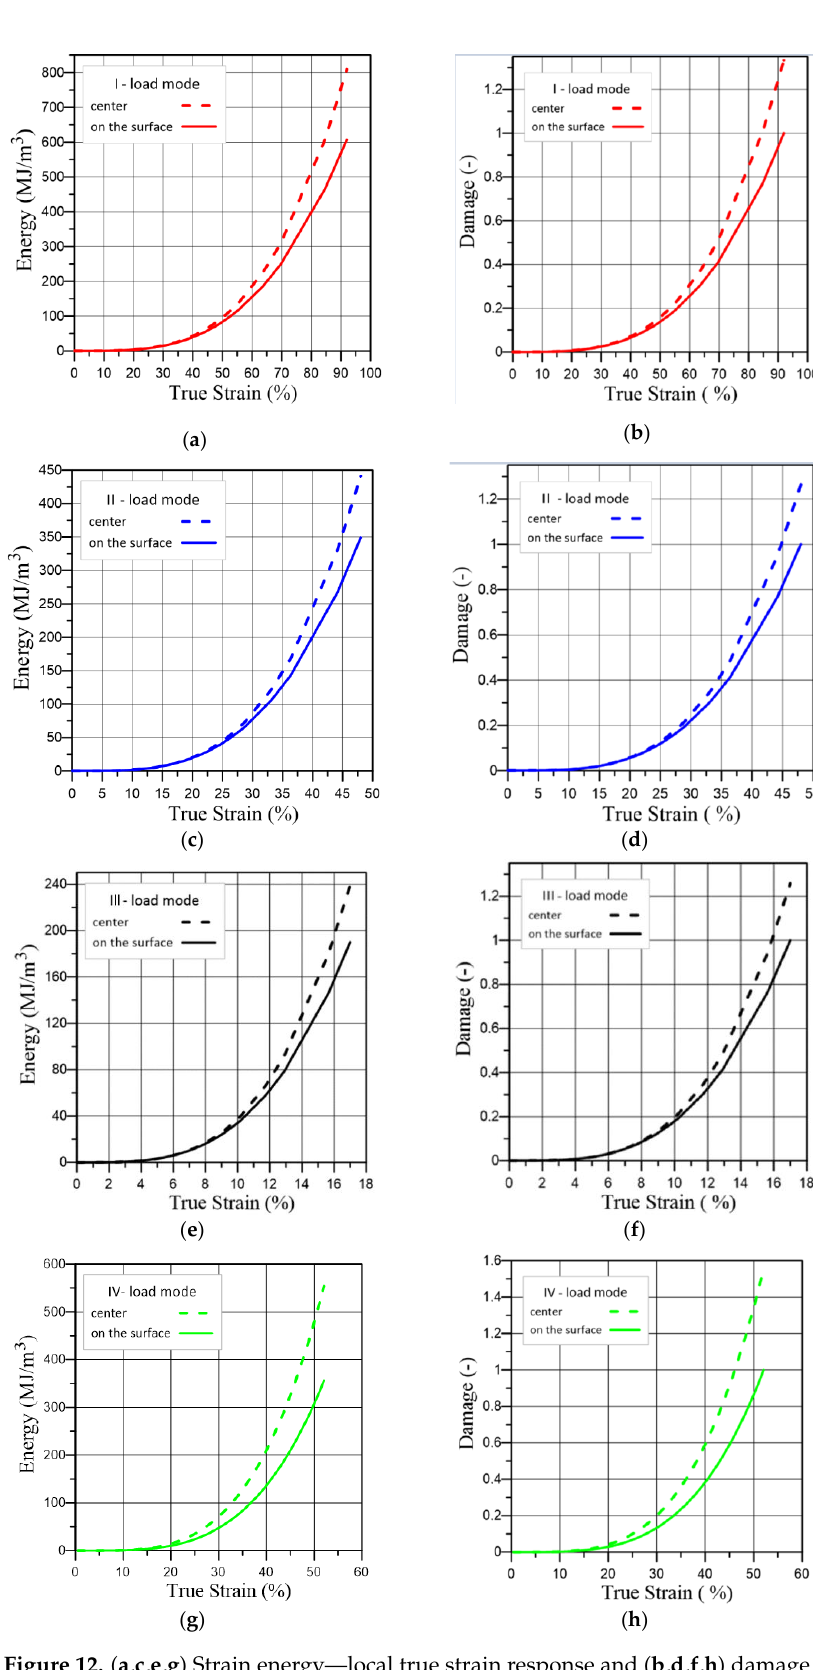
Figure 12. ( a , c , e , g ) Strain energy — local true strain response and ( b , d , f , h ) damage parameter — local true strain response. We observed the same trend for all load modes; namely, the difference between the fracture energy and the damage parameter after a certain strain value. Therefore, when monitoring the stress-strain state of the surface using the ODIC method, it is necessary to take into account the inhomogeneity of the stress-strain state along with the thickness of the structural element and the possibility of the fracture resisting its various parts. As the results of this work show, at a safe level of the surface layers’ strain o n a structural ele- ment, a fracture can already begin inside it.